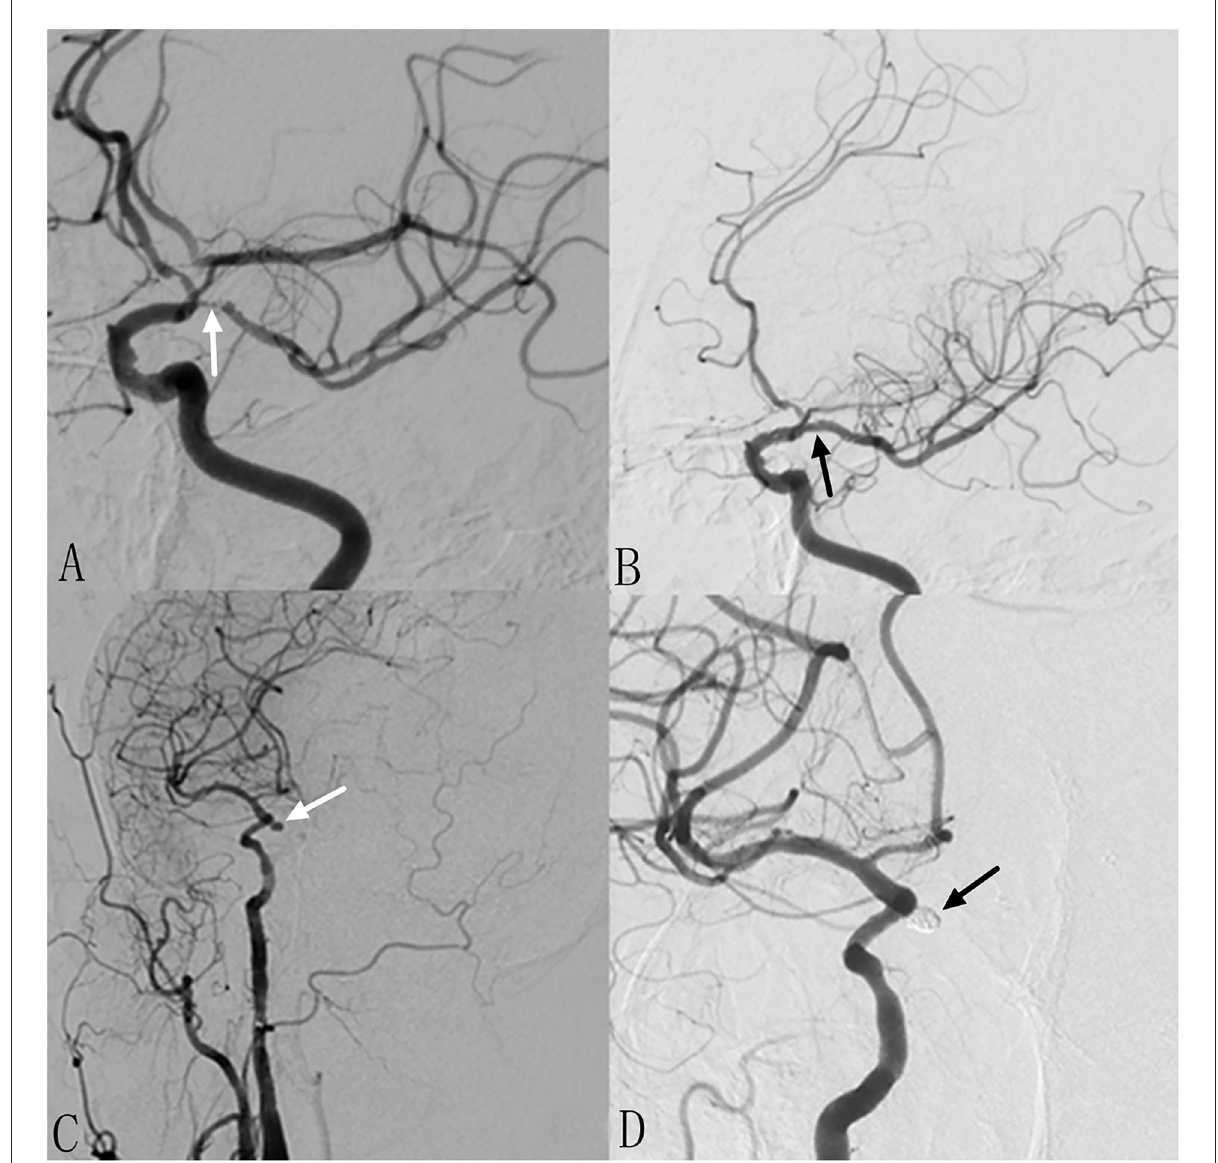
FIGURE3 Patient 15: Separated sessions angioplasty of stenosis and UIA embolization. The patient had weakness in the right limbs for 1 month. DSA showed severe stenosis at left MCA (A) and non-ipsilateral post communicating artery aneurysm (C) . In the first procedure, we performed balloon dilation and stent implantation for the stenosis (B) . One month later, we performed stent assisted coiling of the aneurysm successfully (D)